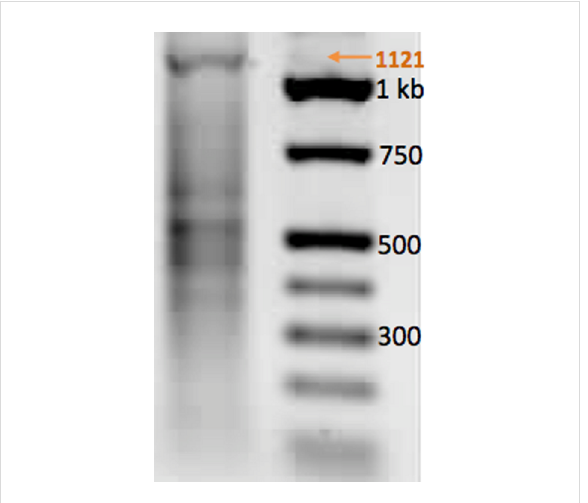
Figure 7: (left) Autonomous assembly of the 32A construct yielded the desired 1,121 base-pair amplicon in a single step involving mixing, annealing, extending, and ligation, followed by PCR amplification (30 cycles). Orange arrow shows the full length product obtained. (right) Ladder of synthetic fragments having lengths indicated